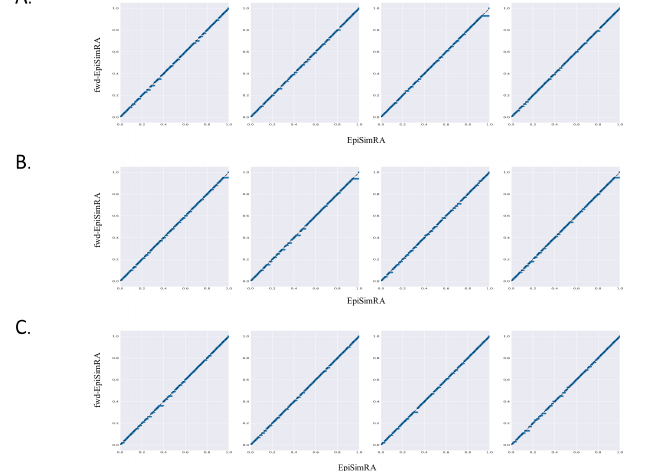
Figure A5. P-P plots of distributions of the height of the ARG (H) between fwd-EpiSimRa and EpiSimRA for ( A ) single locus selection, ( B ) epistatic interaction at two loci and ( C ) epistatic interac- tion at three loci g = 250 K , r = 1.0 × 10 − 8 , N = 100, s = 0.3, e s = { 0,0.1 } and m = { 10,20,30,40 }